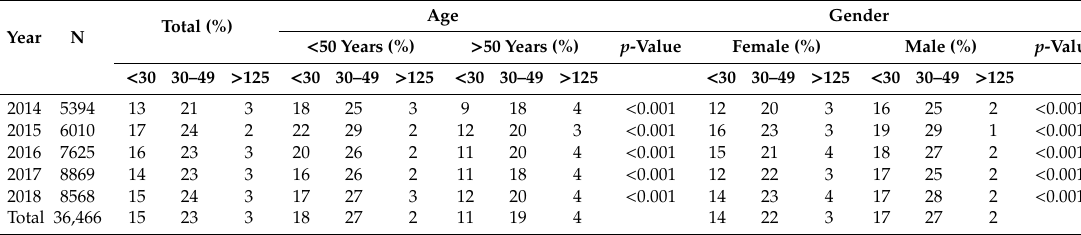
Table 3. 25(OH)D categorised by year, age and gender.